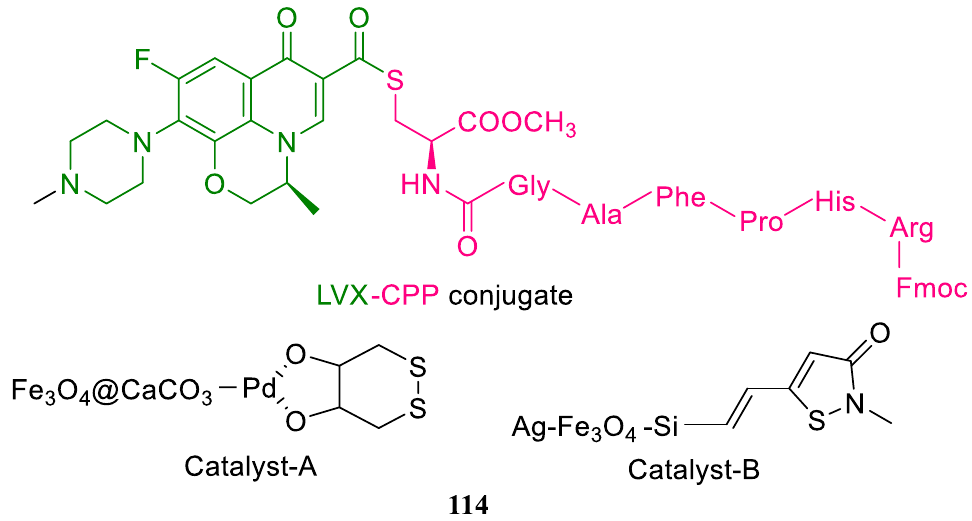
Figure 93. Levofloxacin (LVX) conjugated cell penetrating peptides.